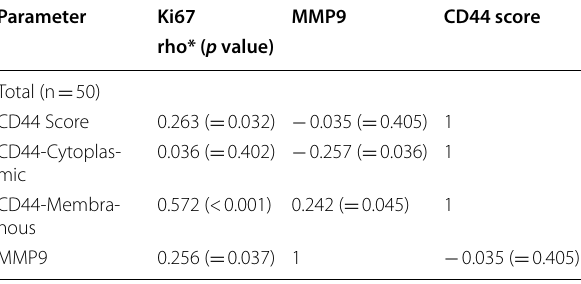
Table 4 The correlation among the expression values of